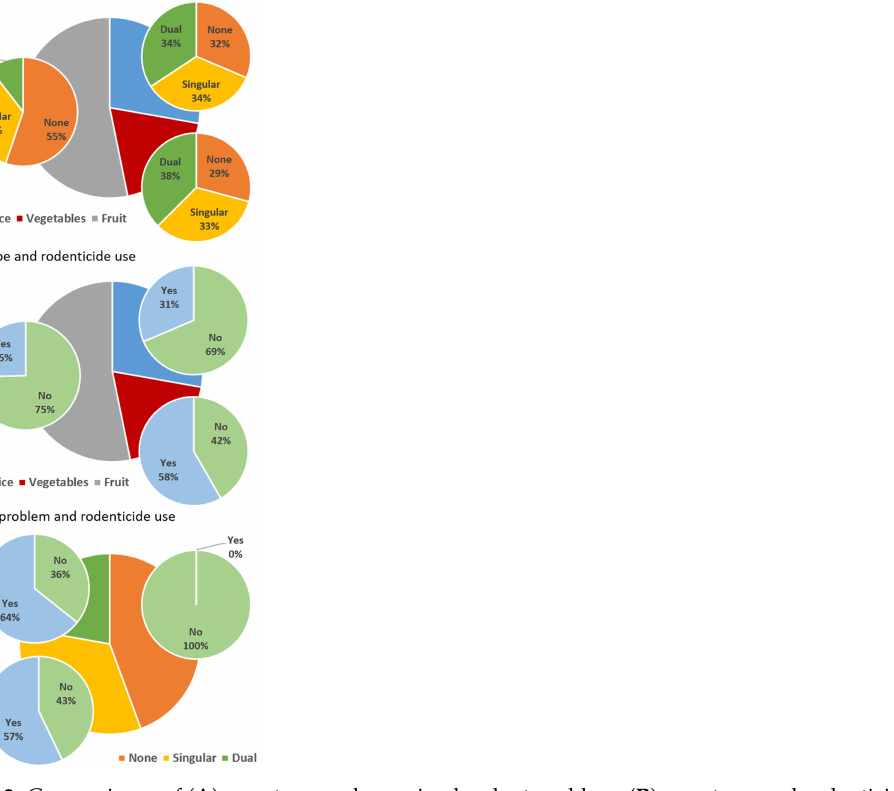
Figure 2. Comparisons of ( A ) crop type and perceived rodent problem, ( B ) crop type and rodenticide Figure2. Comparisonsof( A )croptypeandperceivedrodentproblem,( B )croptypeandrodenticide use,and( C )perceivedrodentproblemandrodenticideuse.Percentagesbasedonfarmers’responses. use, and ( C ) perceived rodent problem and rodenticide use. Percentages based on farmers’